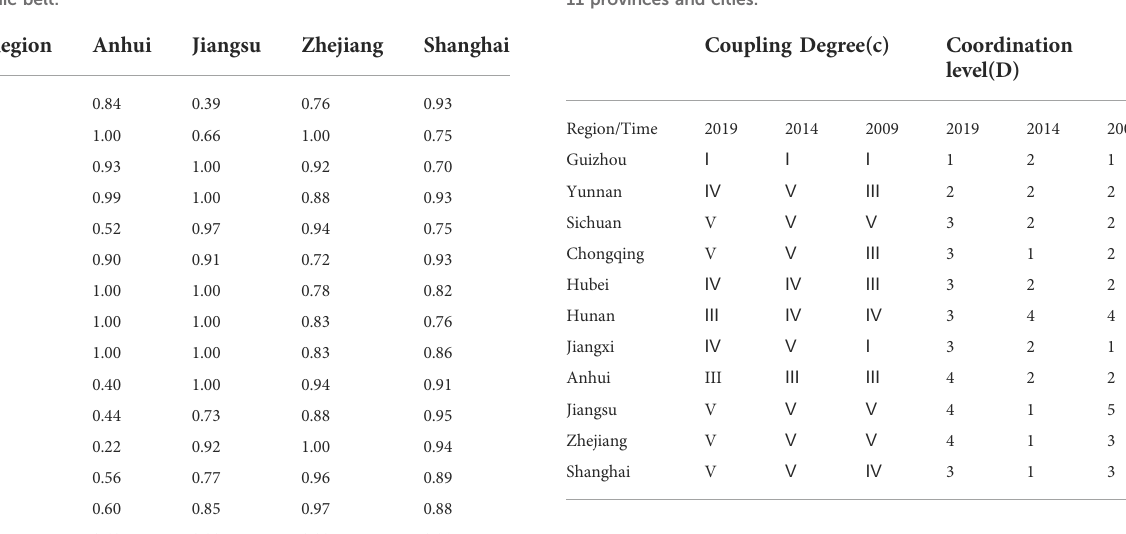
TABLE 8 Five-year evolution of coupling and coordination among 11 provinces and